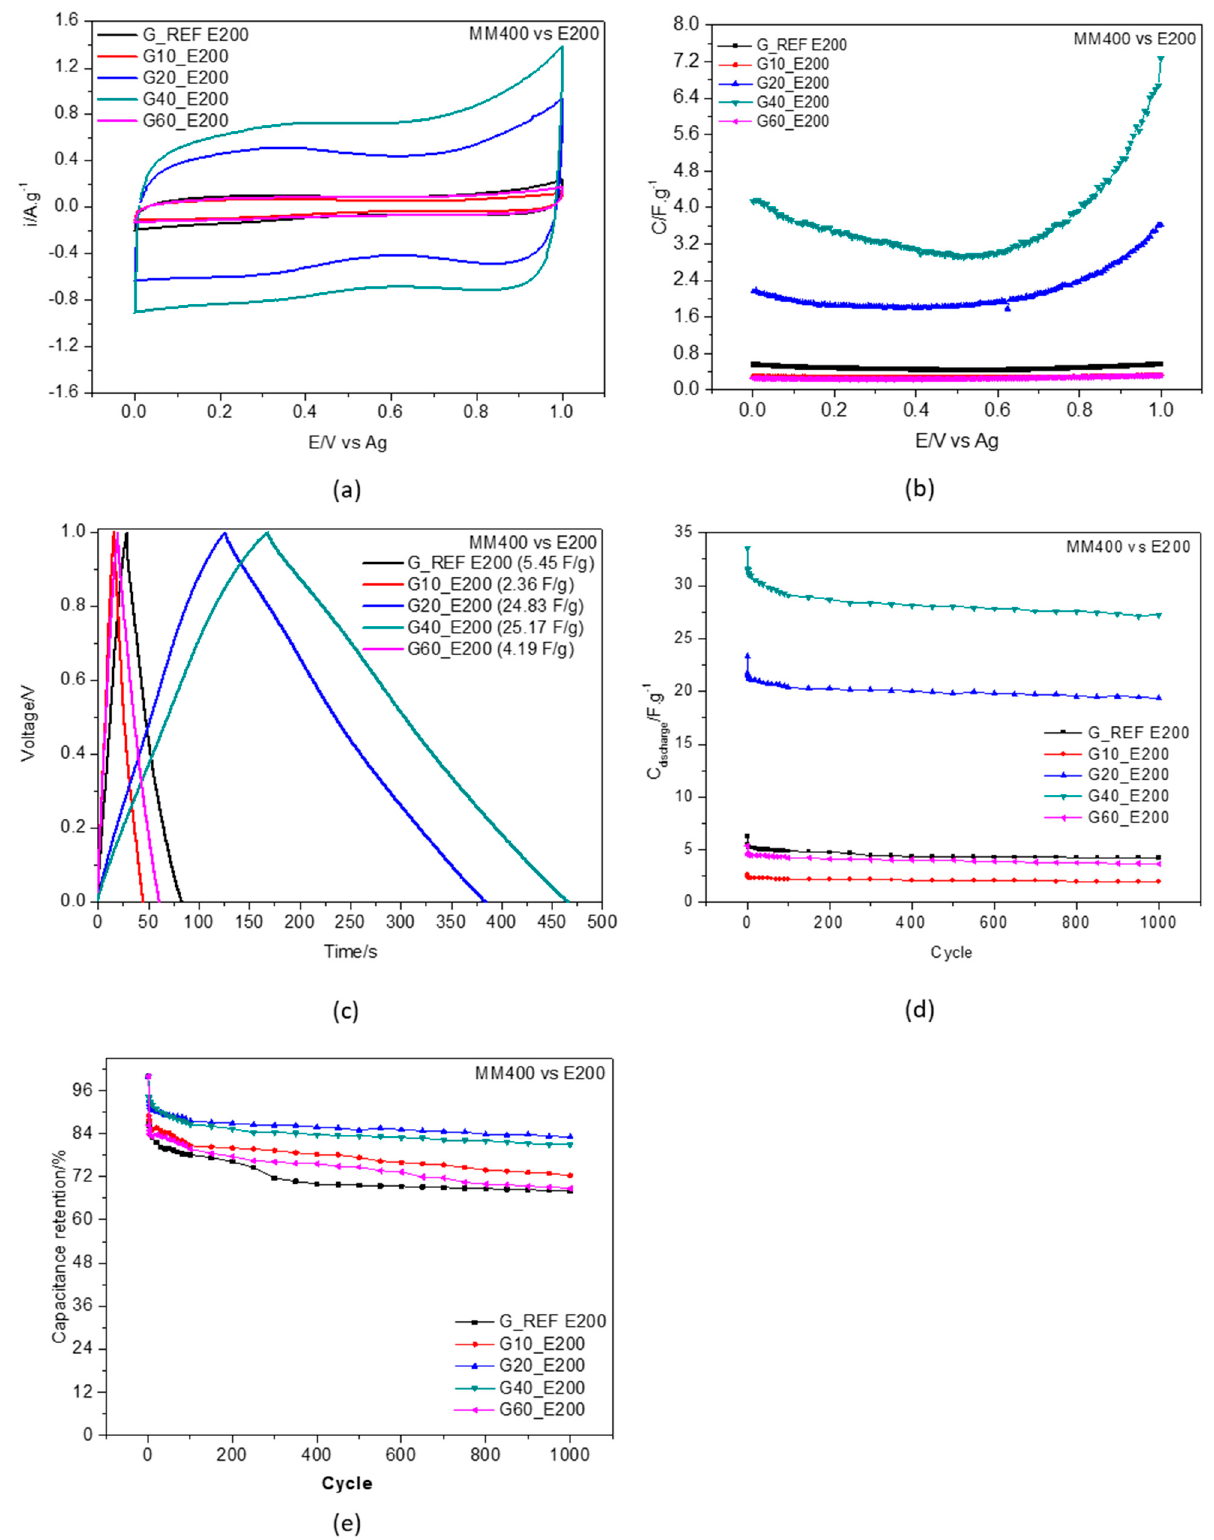
Figure 8. Ball milling effect using Retsch Mixer Mill MM400 for G_REF, G10, G20, G40, and G60 at 30 °C in E200. ( a ) cyclic voltammetry at scan rate of 50 mV.s − 1 at 30 °C; ( b ) capacitance–potential curve; ( c ) galvanostatic charge–discharge curves recorded with current density 1 A·g − 1 ; ( d ) discharge gravimetric capacitance for 1000 cycles; ( e ) capacitance retention (at 1 A·g − 1 ).